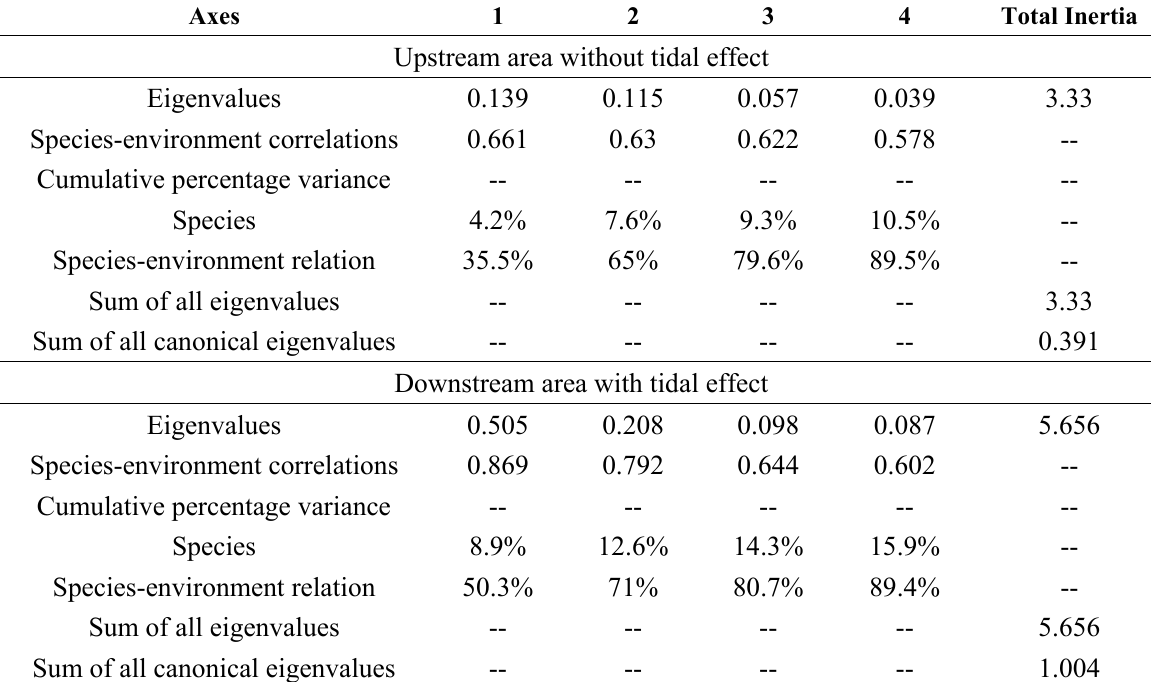
Table 2. The result of canonical correlation analysis between environmental factors and fish taxa of the Tanshui River system in 2012. Sampling sites were divided into two groups, upstream area without tidal effect and downstream area with tidal